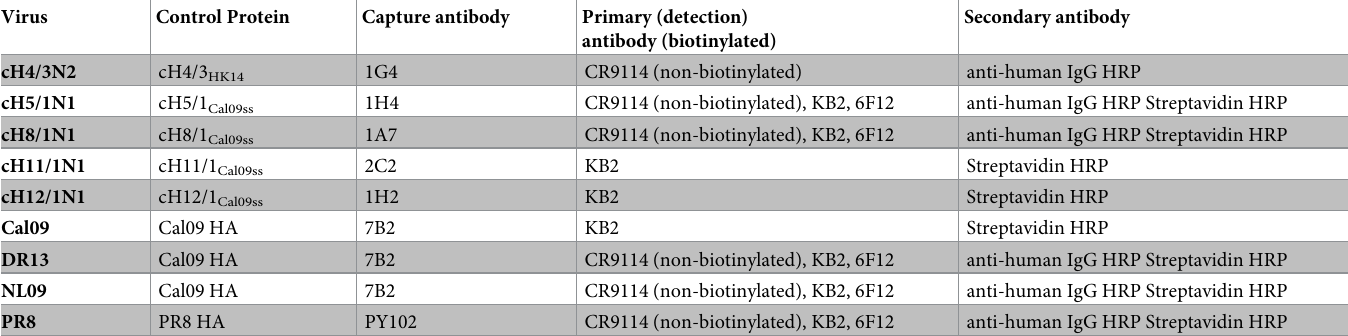
Table 2. ELISA reagents used for capture